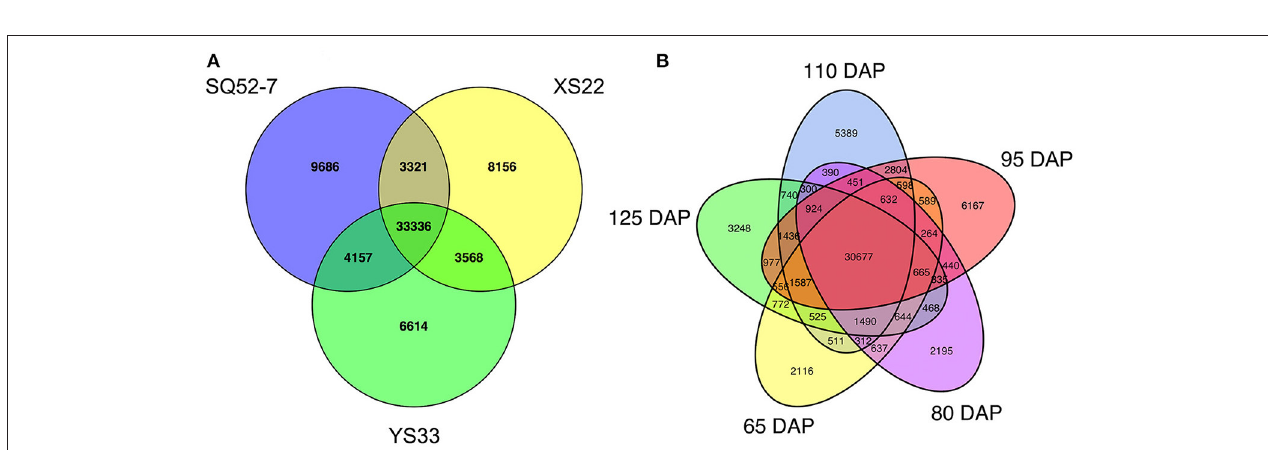
FIGURE 5 | Expressed unigenes identified in the 15 sweet potato SRs. Venn diagrams were generated to identify sweet potato (A) genotype- and (B) developmental stage-specific expressed unigenes and common expressed